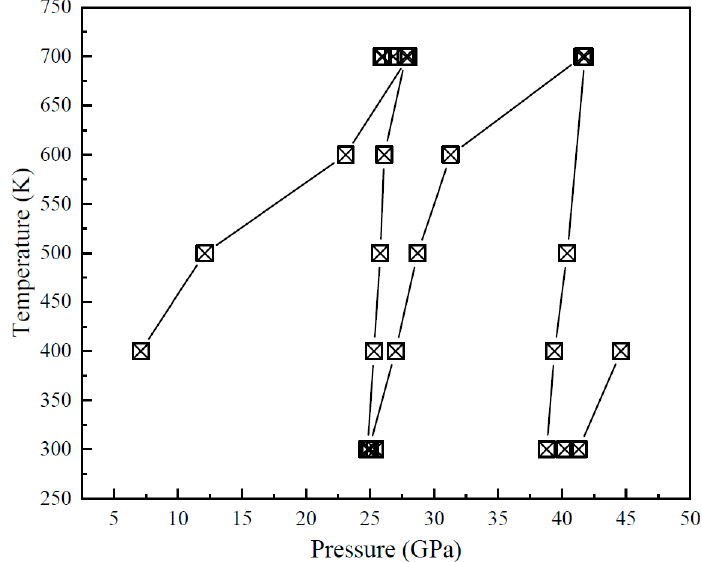
Figure 1. Pressure-temperature path of the HPHT XRD experiments. The square signals represent the corresponding pressure and temperature where the HPHT data sets were obtained. The black line is just a guild for eyes.